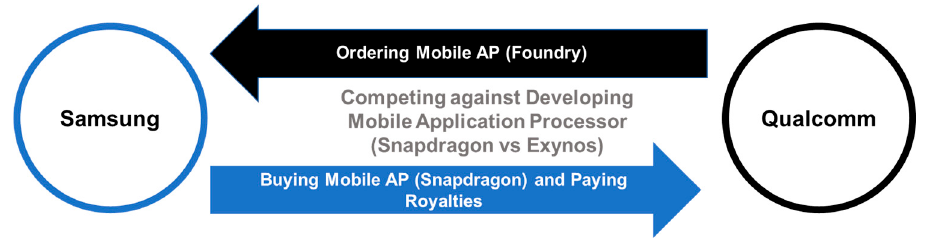
Figure 2. Coopetitive relationship of Qualcomm and Samsung.